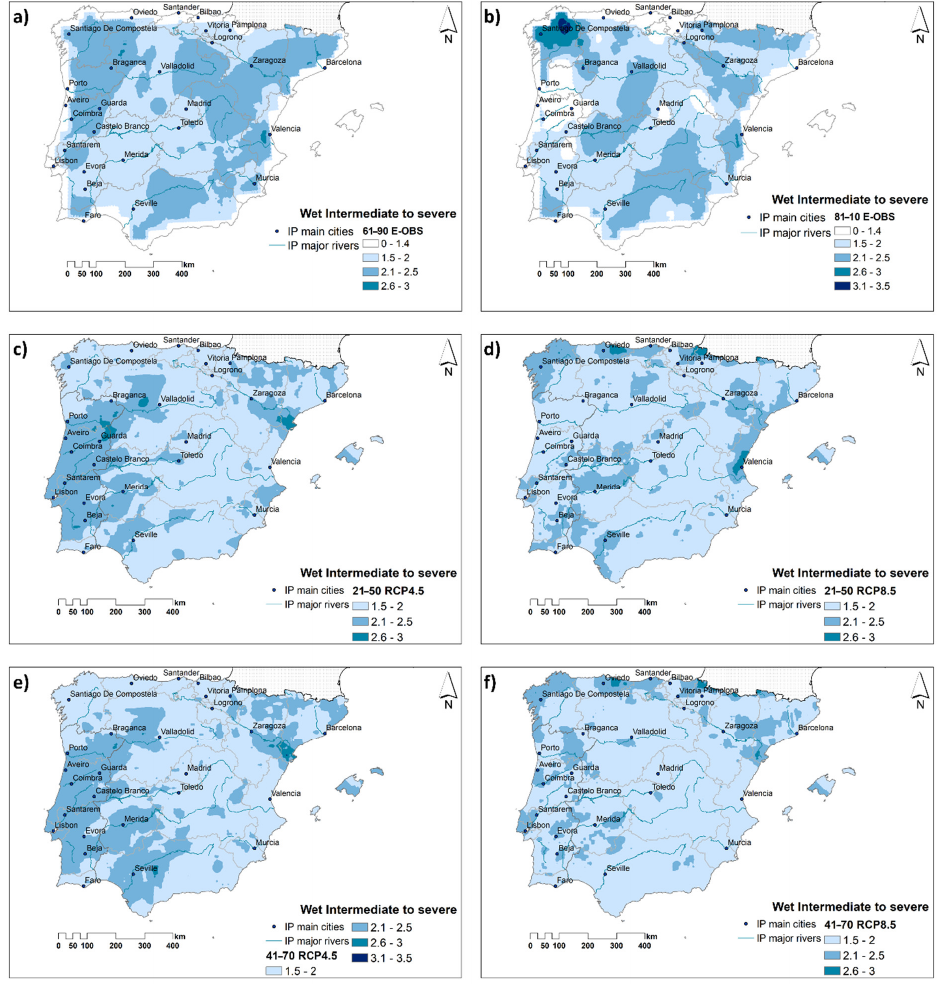
Figure 7. Intensity of 12m-WASP intermediate-to-severe wet events in IP for the periods ( a ) 1961–1990 and, ( b ) 1981–2010, ( c , d ) 2021–2050, ( e , f ) 2041–2070 under RCP4.5 (left) and RCP8.5 (right) (Note: NUTS 2 in grey contours). Although ID conditions prevailed over the two past periods (Figure 8a,c) in the west- ernmost half of the IP from 2021 onwards (Figure 8a–c), most of the territory may experi- ence SD conditions, mainly for RCP4.5 and 2041–2070 (Figure 8e). Similar results were found for RCP8.5, projecting areas of ID conditions in Galicia, Castilla y Léon, Aragón, and Valencia, in Spain, and Centro and Norte, in Portugal (Figure 8d,f).